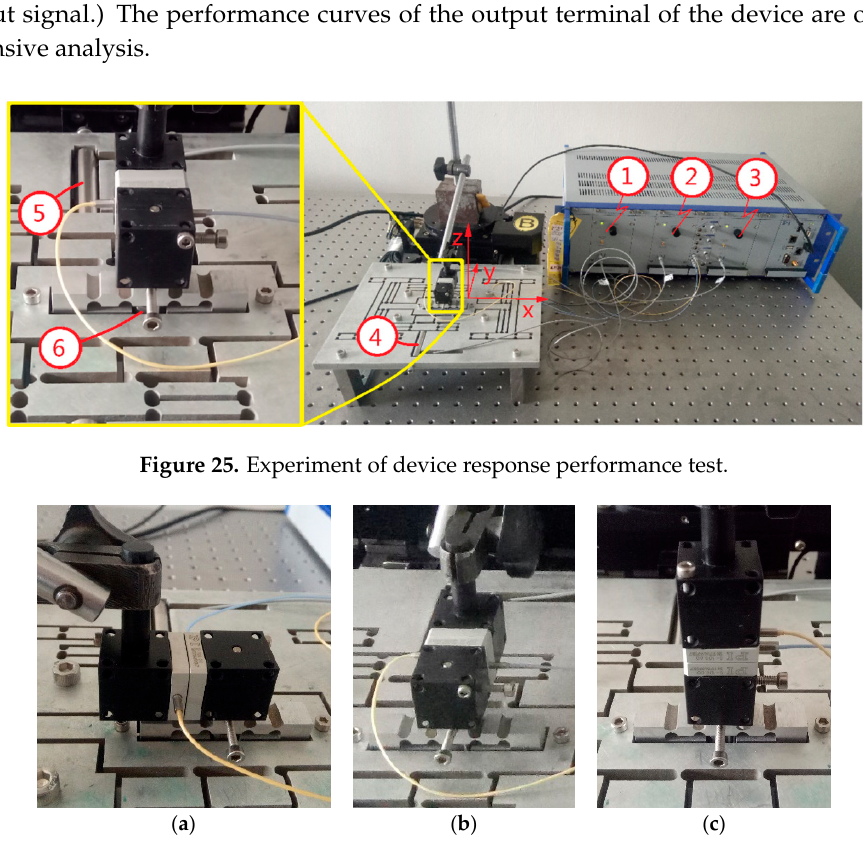
Figure 26. Capacitive sensor installation in all directions. ( a ) x -direction test; ( b ) y -direction test; ( c ) z -direction test.